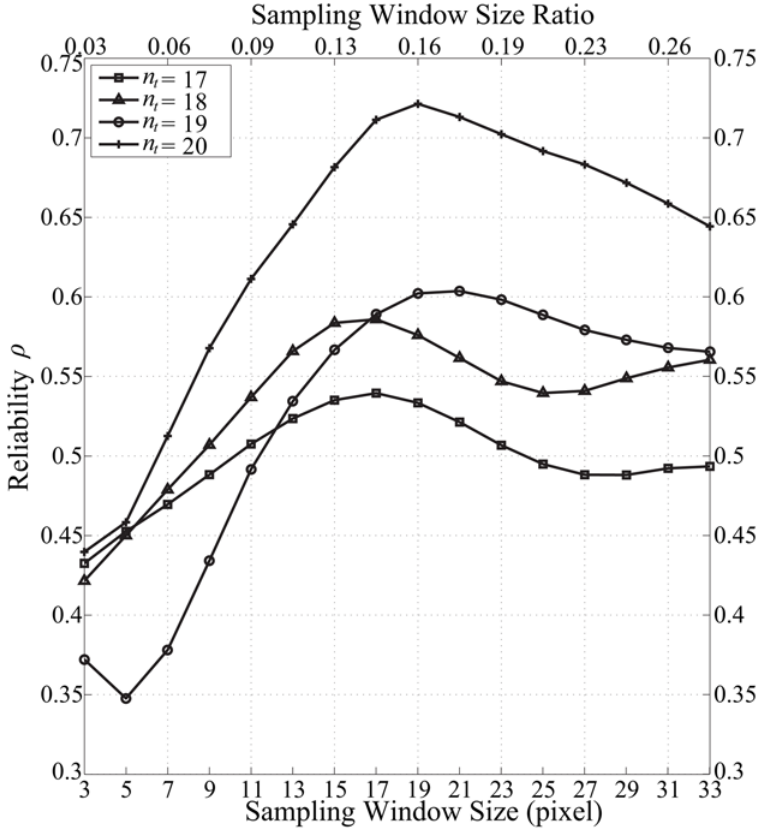
Figure 12. Reliability study using predicted and true variance. Reliability for the predicted MR fluid motion field data, r with respect to the phase contrast MRI data (taken as the true data) is computed. The variation of vorticity sampling window size can affect the reliability of computational measurement of the vorticity.